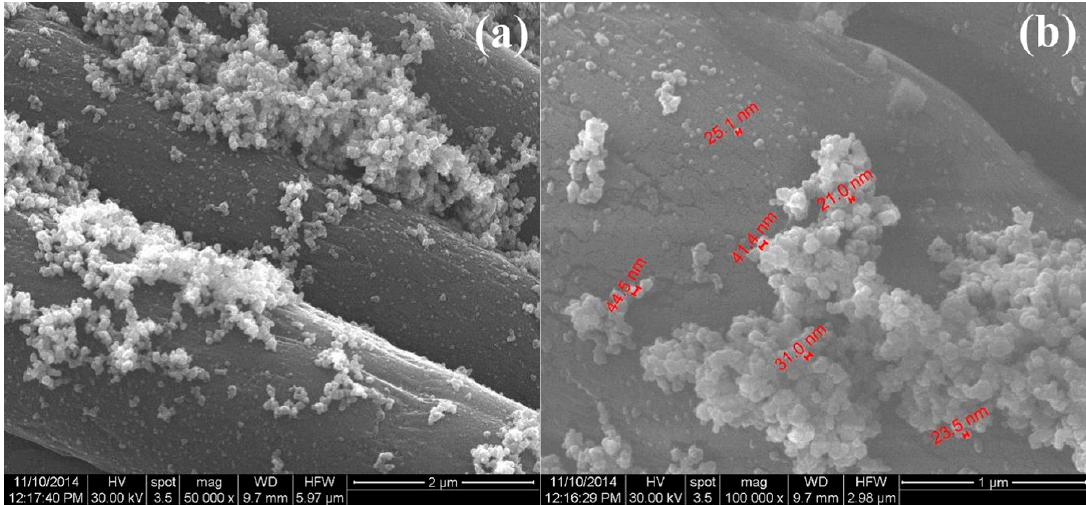
Figure 2. SEM images of NanoAg-WDs at various magnifications: ( a ) 50,000×; and ( b ) 100,000×.